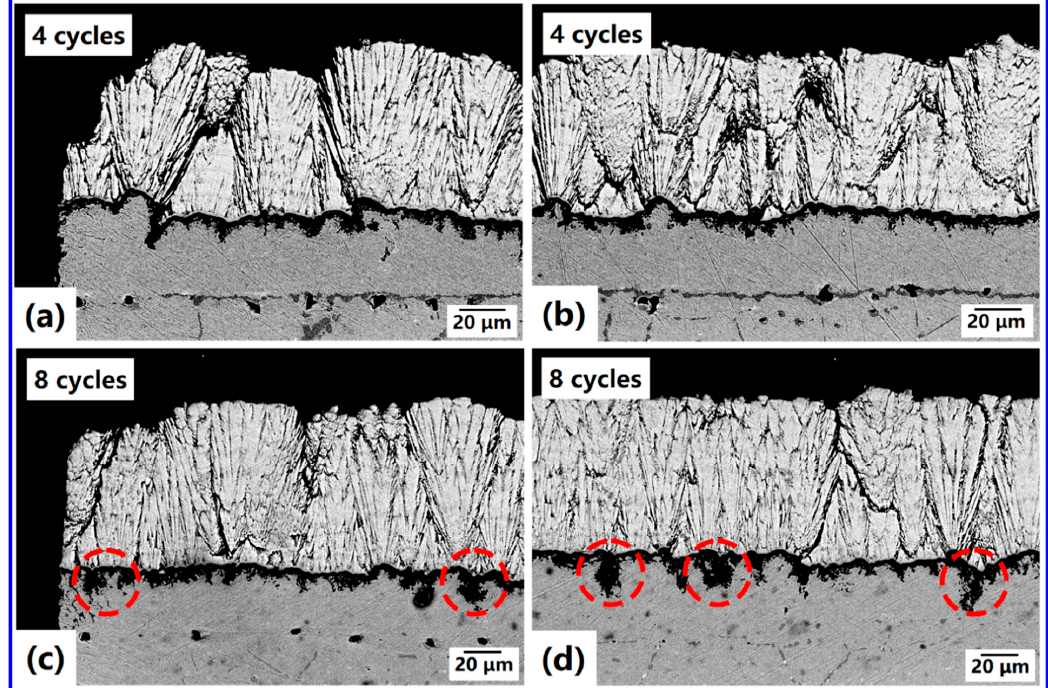
Figure 8. Cross-sectional morphologies of YSZ without NaCl: ( a ) edge of coating after four cycles; ( b ) center of coating after four cycles; ( c ) edge of coating after eight cycles; ( d ) center of coating after eight cycles. The area shown by the red circles clearly shows the growth of TGO.